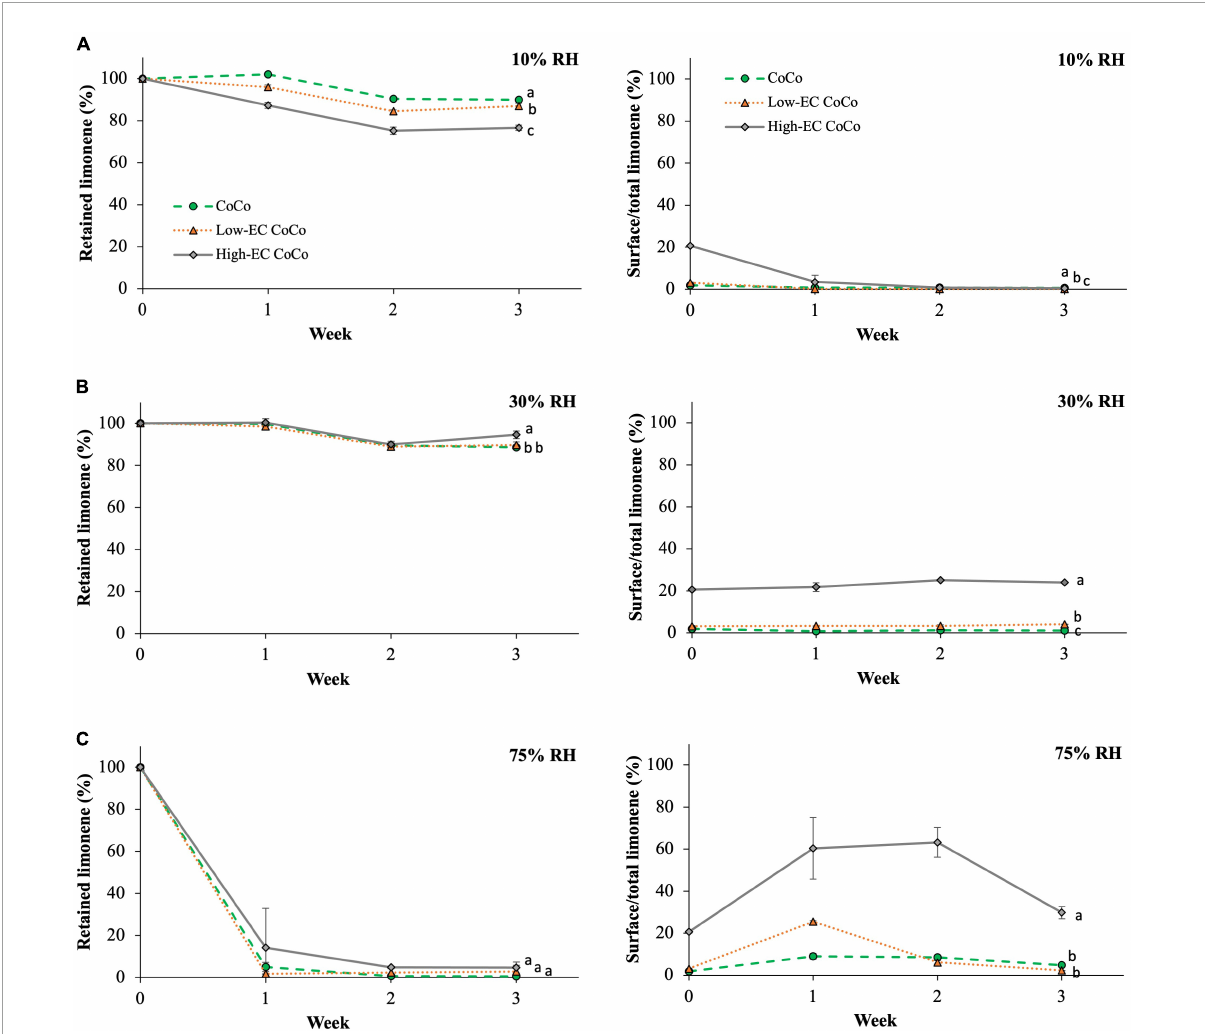
FIGURE3 The volatile retention of limonene and the surface limonene content in microcapsules stored at room temperature and (A) 10% RH, (B) 30% RH, and (C) 75% RH. Lines are drawn to guide the eye. Different letters indicate statistically significant differences between different formulations at selected time points.